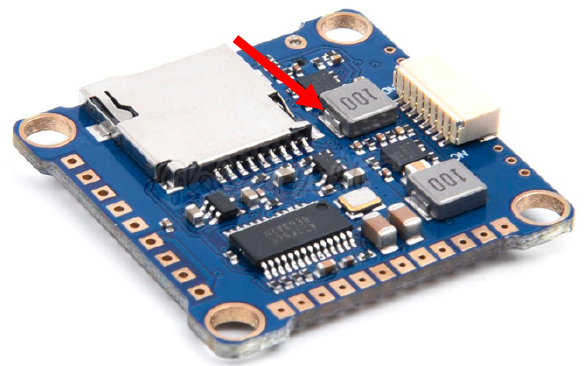
Figure 5. The SD card slot on the bottom side of the flight controller.